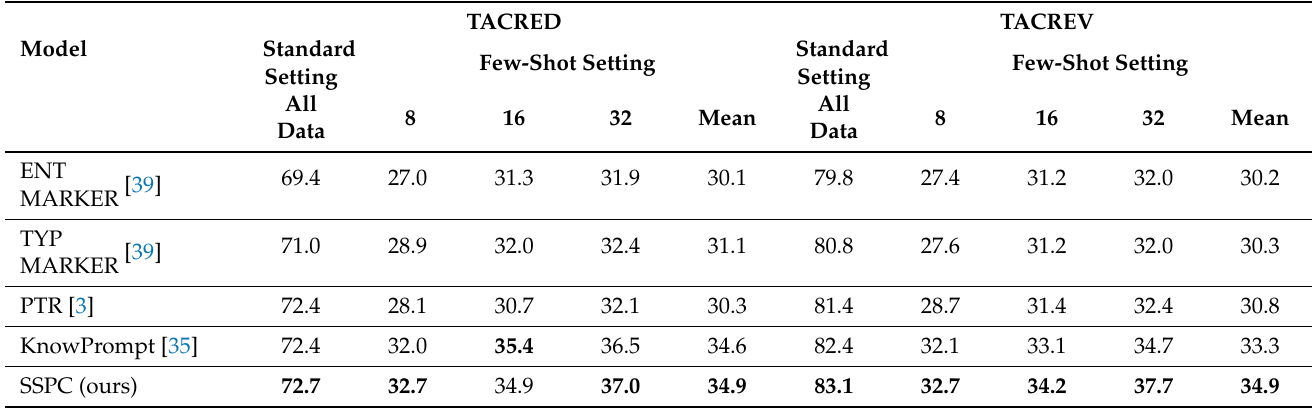
Table 4. Our experimental results on the datasets TACRED and TACREV. F 1 scores of various models with different sizes of training instances.The best results are bold.